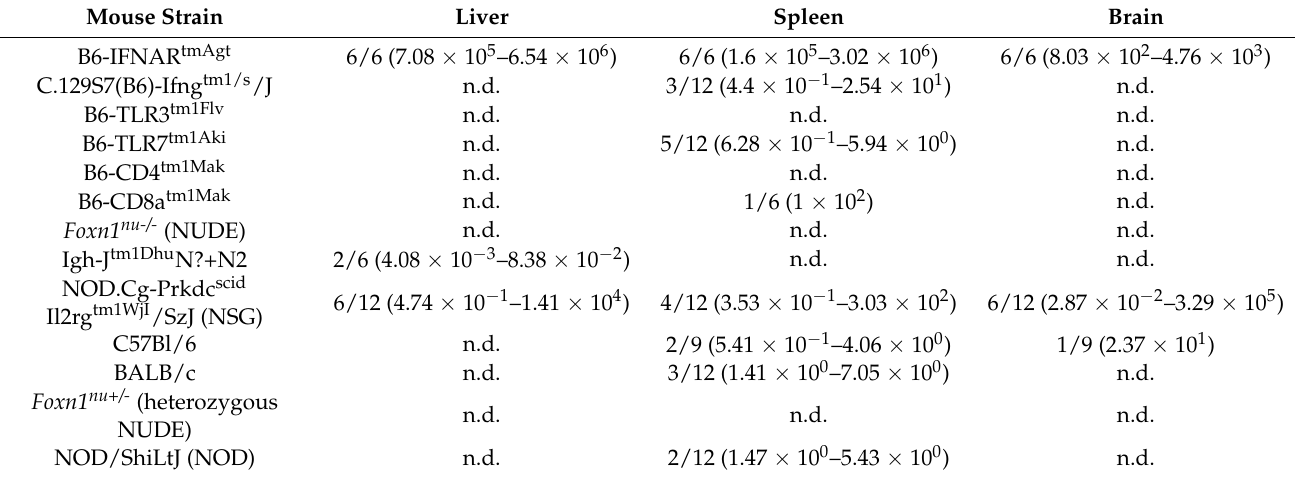
Table 3. RT-qPCR detection of RVFV RNA shown as positive animals/mouse strain and copies/ µ L RNA in liver, spleen and brain.